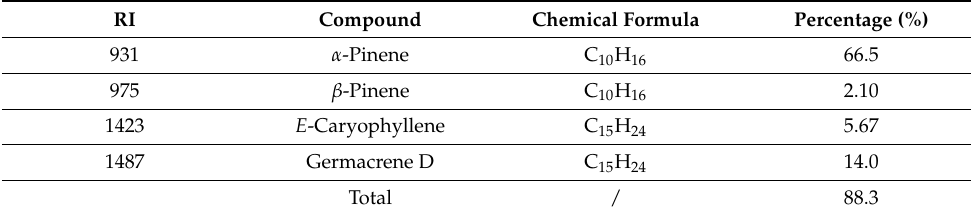
Table 1. Dominant compounds of the essential oil of Pinus nigra